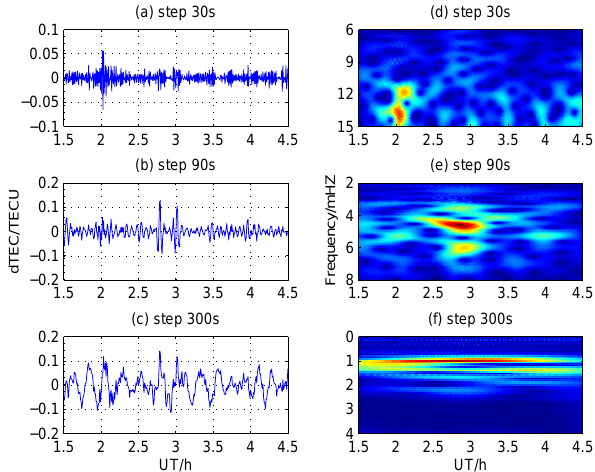
Figure 4. The disturbance series extracted by multi-step multi-order numerical difference method at station CHAN. The order is set to 2. Panels (a – c) present the results of time steps 30, 90 and 300s, respectively. Panels (d – f) are the corresponding spectrograms.